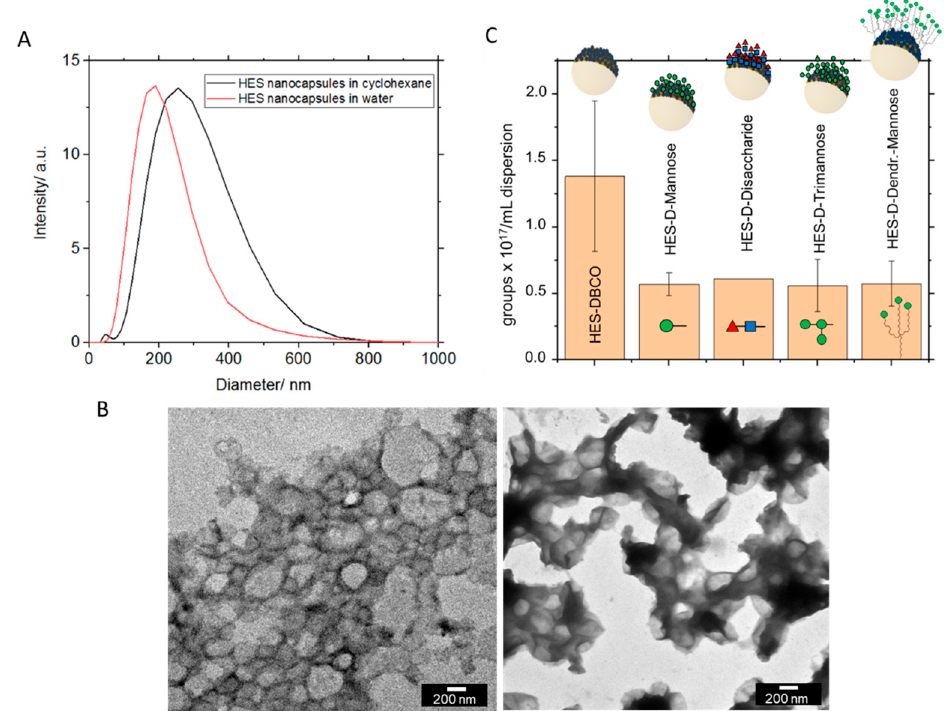
Figure 2. ( A ) Average size distribution of four hydroxyethyl starch (HES) nanocapsule batches in cyclohexane and in water measured at an angle of 90°. ( B ) TEM micrograph of HES nanocapsules in cyclohexane (left) and in water (right). ( C ) Quantification of free dibenzocycloocytne (DBCO) groups and DBCO groups clicked to functionalized carbohydrates per mL dispersion by a fluorescent assay.